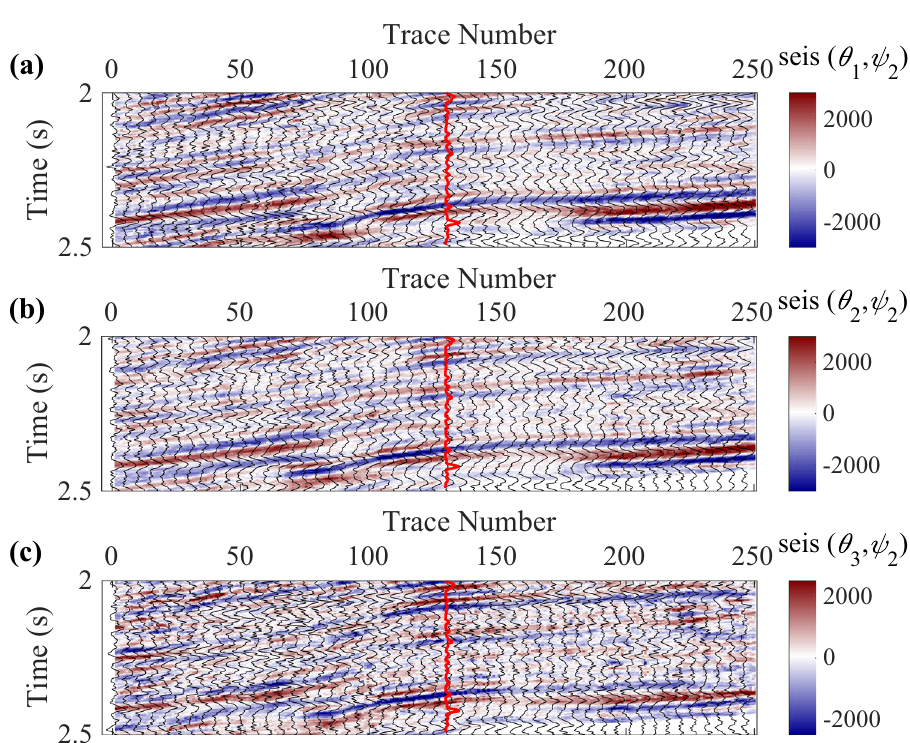
Figure 5. Angle-stacked seismic data in the other azimuth ϕ 2 = 130 ◦ , where (a) is the near angle of incidence, (b) is the middle angle of incidence, and (c) is the far angle of incidence,